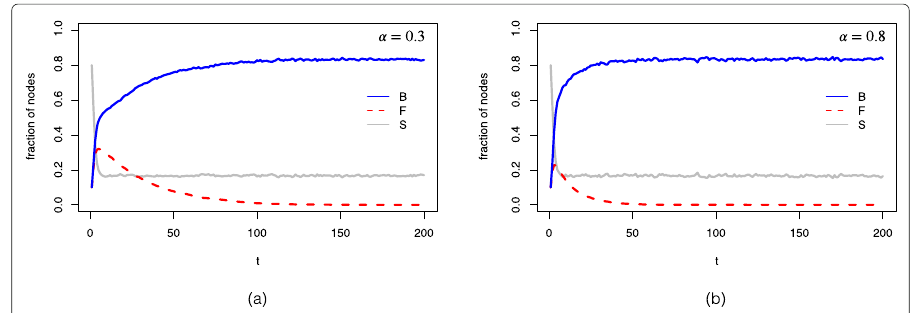
Fig. 3 Scale-Free Network: dynamics of the model on a Barabasi-Albert network of N = 1000 nodes, starting with B 0 = 100 seeders Believer and F 0 = 100 seeders Fact Checker. Each plot refers to the averaged value of densities over 20 simulations. For different values of credibility ( α = 0.3 in ( a ) and α = 0.8 in ( b )), we have the same configuration at the equilibrium: the debunking dies out, whereas the misinformation becomes